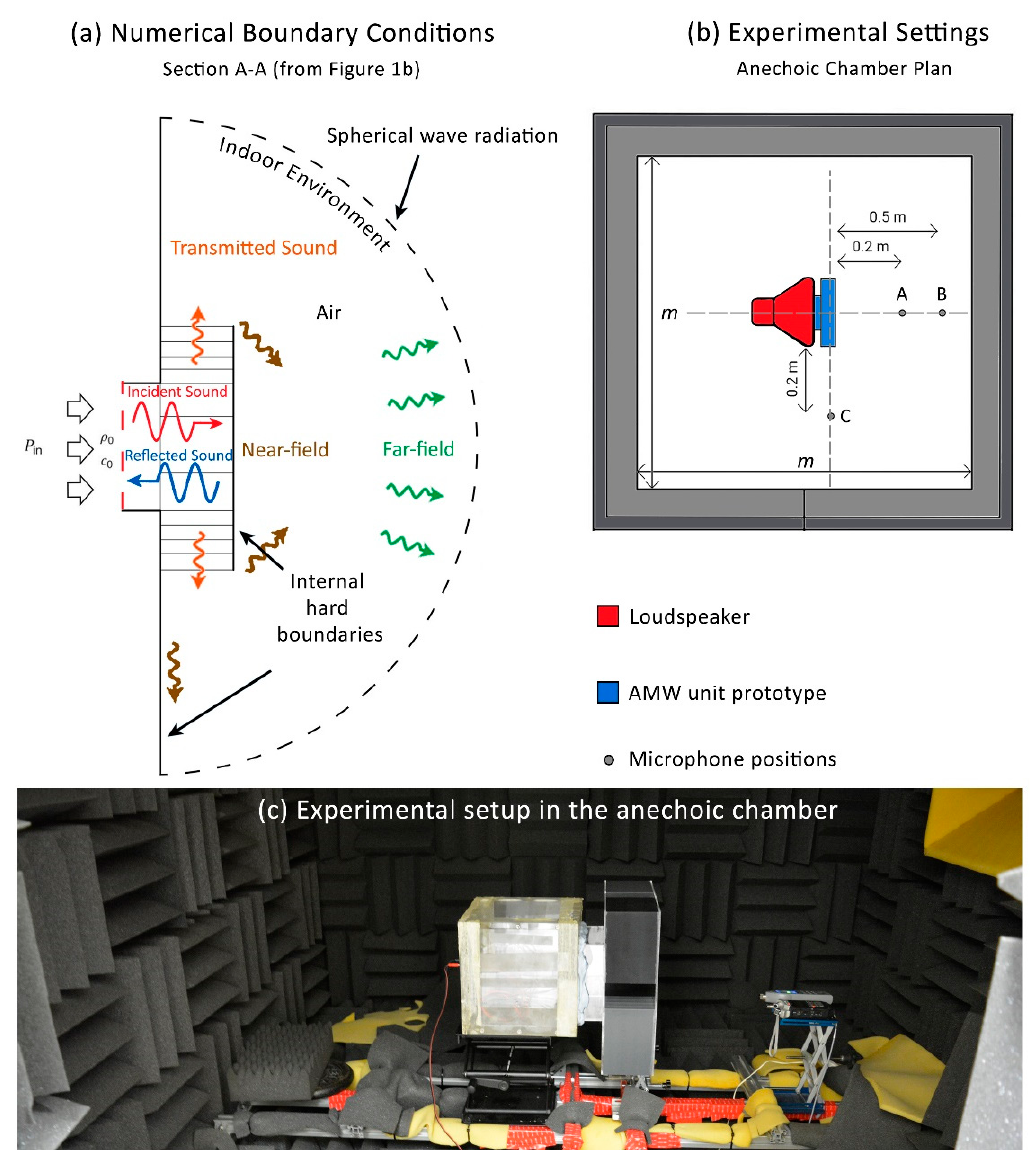
Figure 2. ( a ) Schematic of boundary conditions used in numerical acoustics simulations; ( b ) 2D representation of experimental settings with m = 2 m being the length of the anechoic chamber’s inner area; ( c ) photograph of the experimental setup in the anechoic chamber.